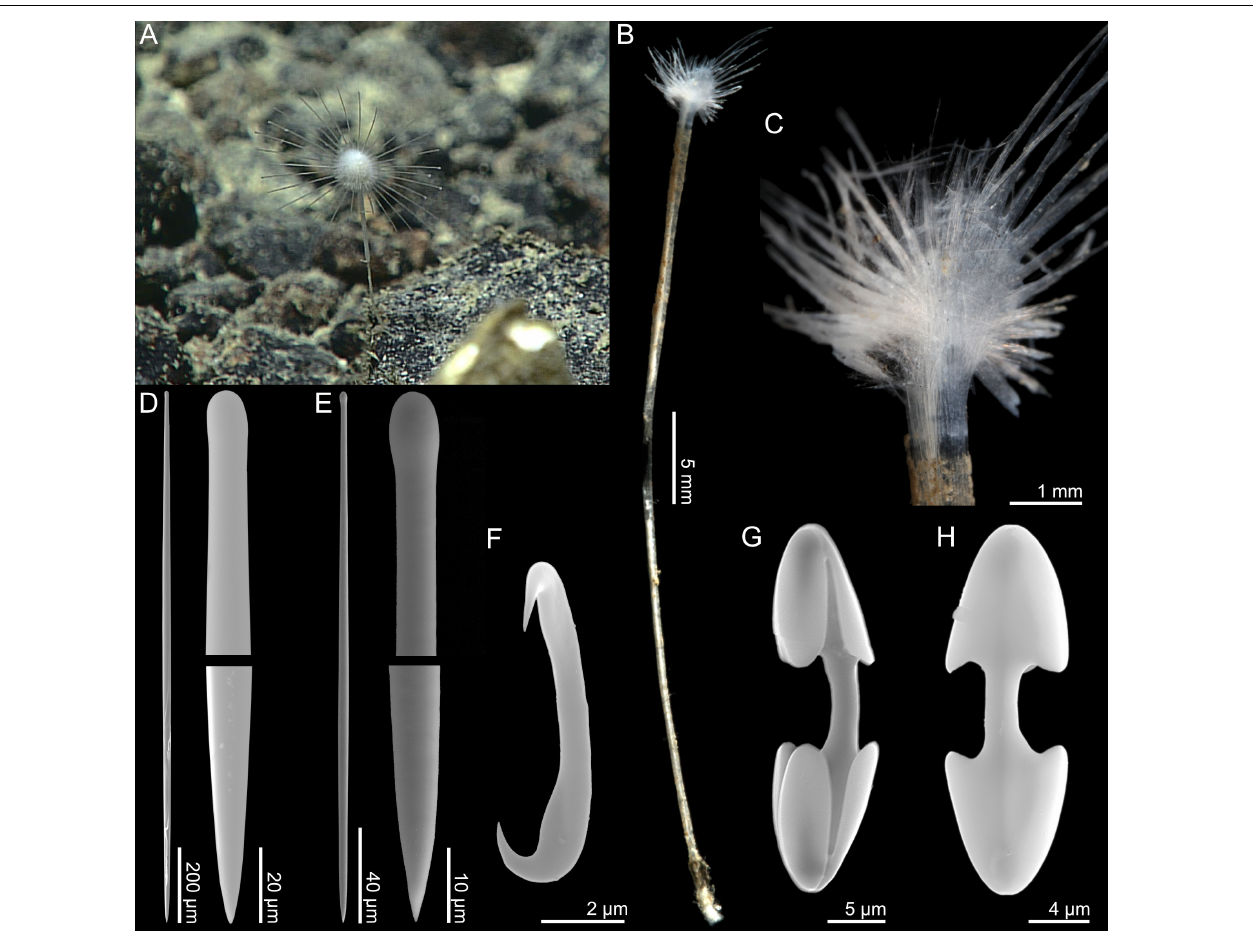
FIGURE 5 | Abyssocladia stegosaurensis n. sp. (A) In situ image from ROV feed, (B) whole specimen, (C) detail, (D) mycalostyle, (E) tylostyle, (F) sigmancistra, (G) palmate chela front view, and (H) palmate chela back view.